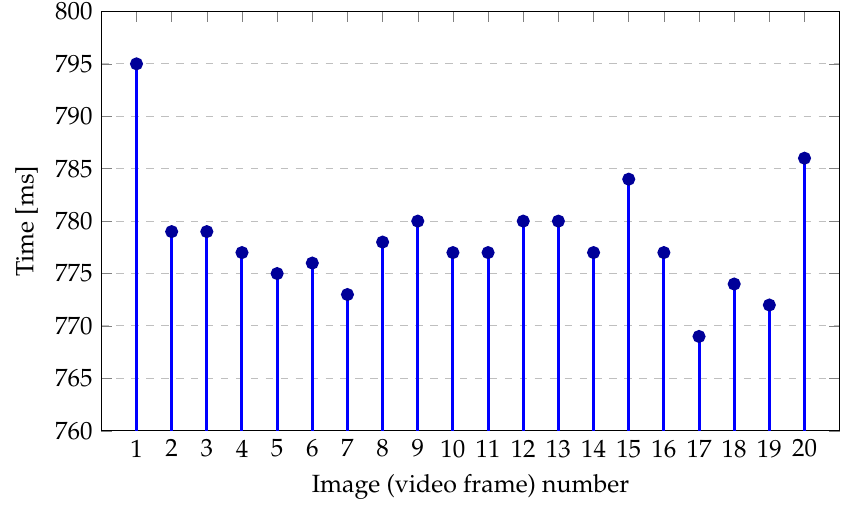
Figure 8. Time performance for bee